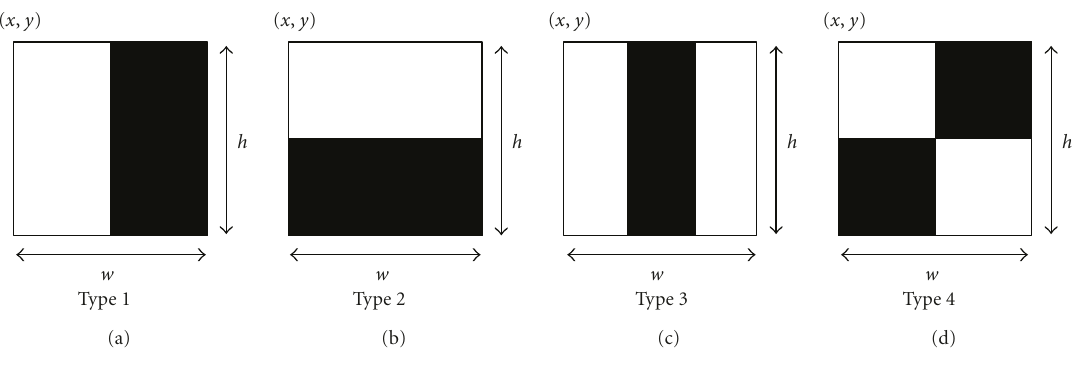
Figure 5: Four types of rectangle